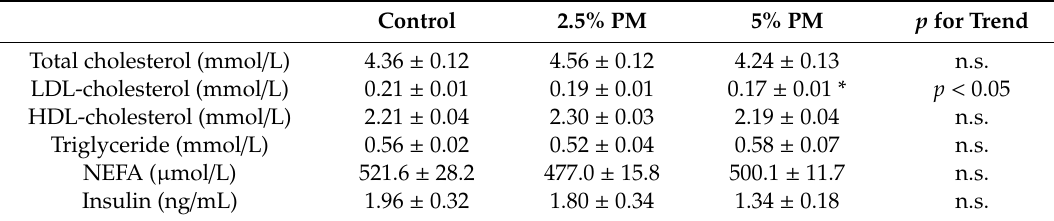
Table 7. Biochemical analysis of the serum.